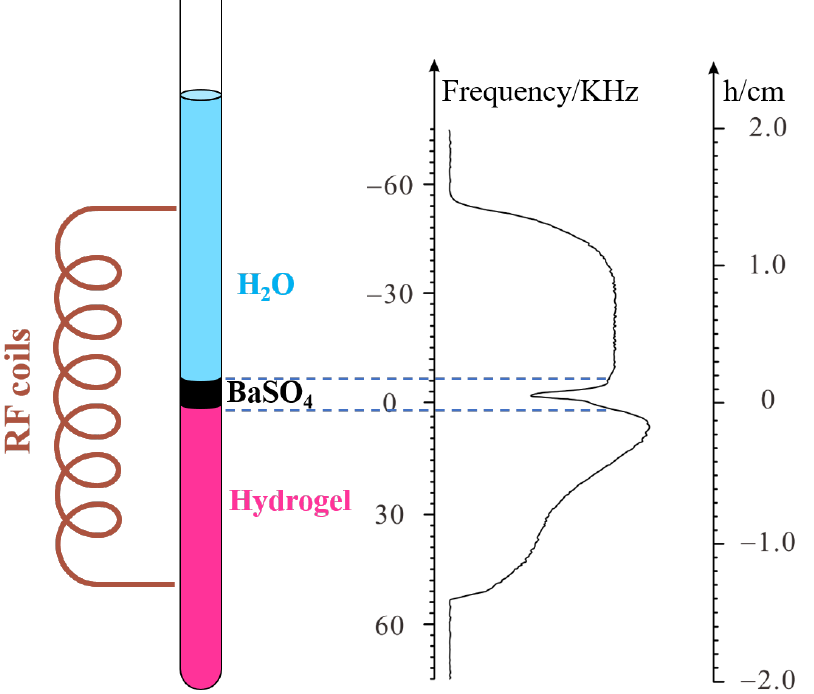
Figure 3. The spatial position of the NMR tube corresponds to the gradient profile. The brown represents the RF coil, and in the left NMR tube schematic diagram, the gel represents pink, the barium sulfate precipitate is black, and the water is blue from the bottom up.